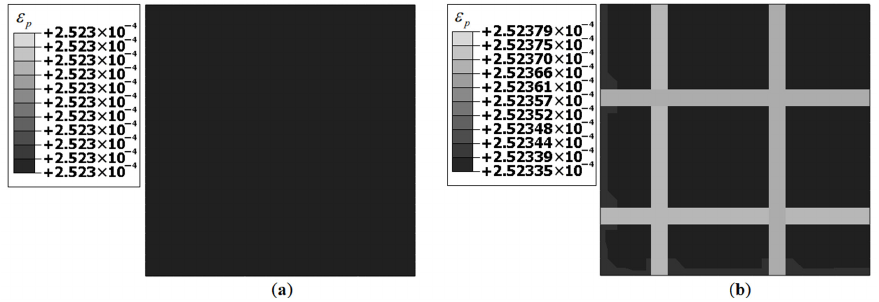
Figure 4. Contour plots of 𝜀 (cid:3043) for an undamaged plate: ( a ) FE results, and ( b ) benchmark iFEM results.